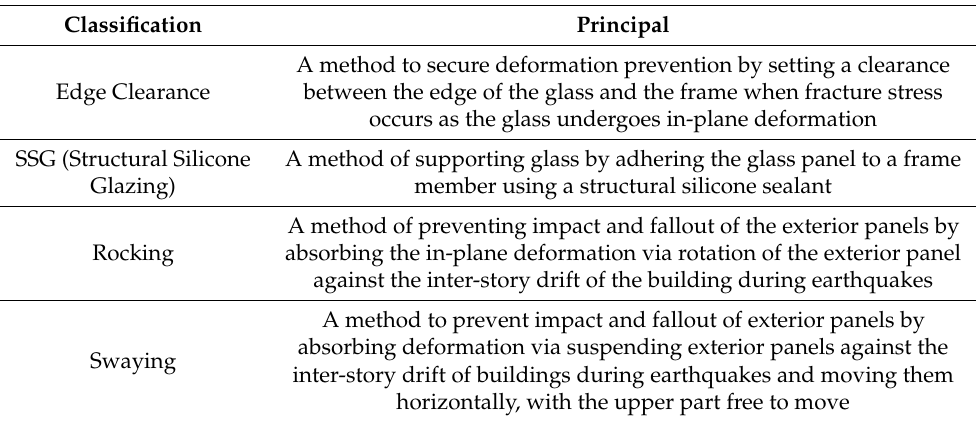
Table 1. Methods to reinforce the seismic performance of curtain